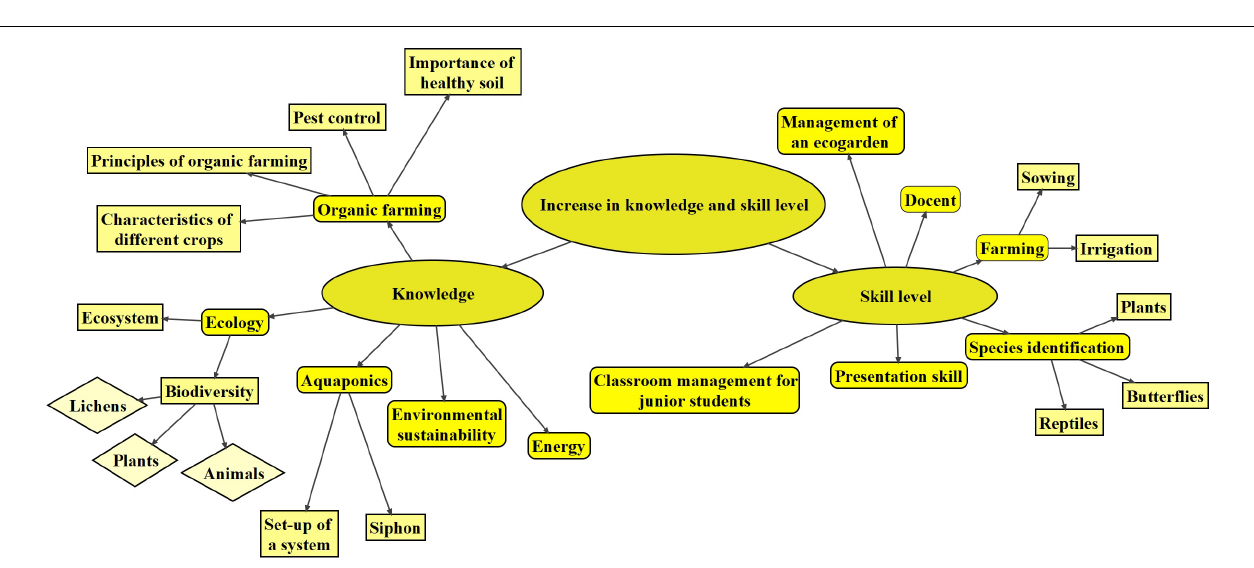
FIGURE 3 | Mapping of the codes under the theme ‘Increase in knowledge and skill level.’ Different shapes refer to different levels of themes.